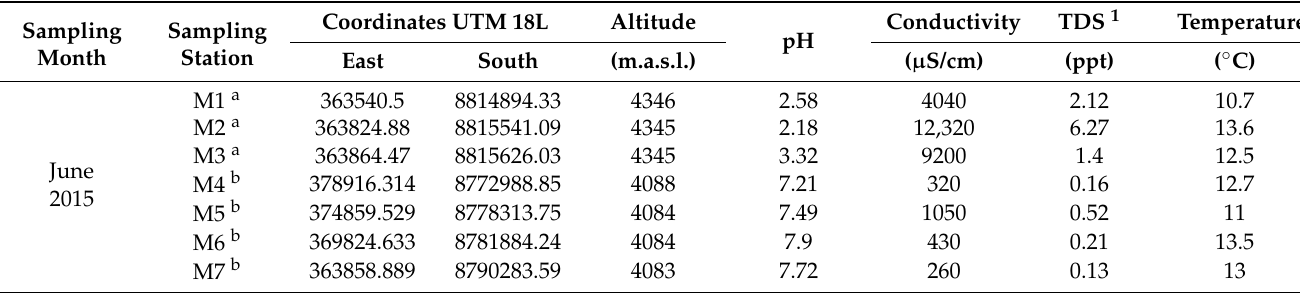
Table 1. Sampling stations and averages of physicochemical parameters of the samples collected from Lake Jun í n and the Yanamate